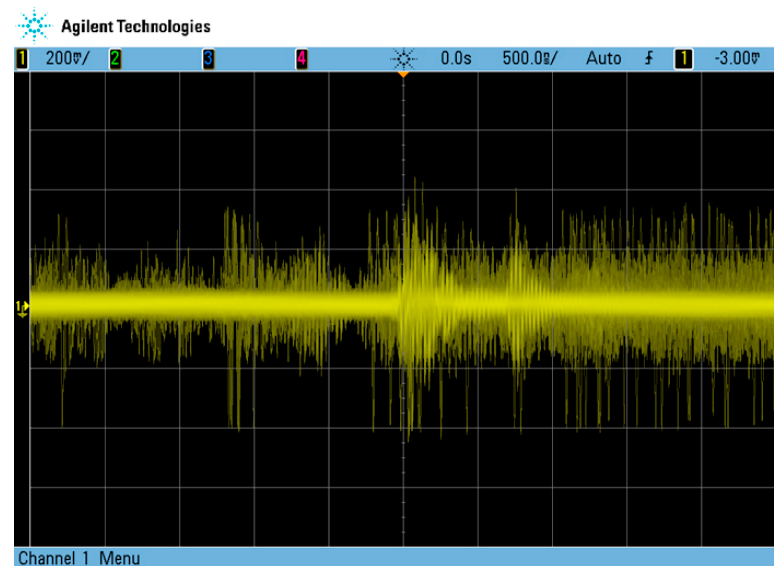
Figure 19. Voltage ripple of the 50 V DC bus with the first prototype of the converter.